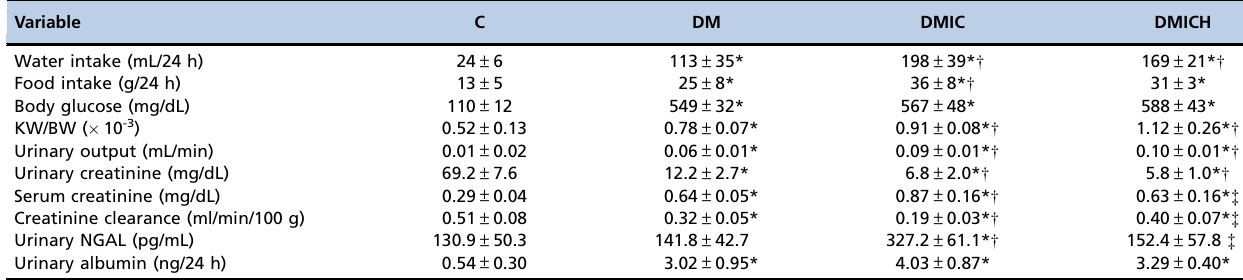
Table 1 - Physiological parameters and kidney